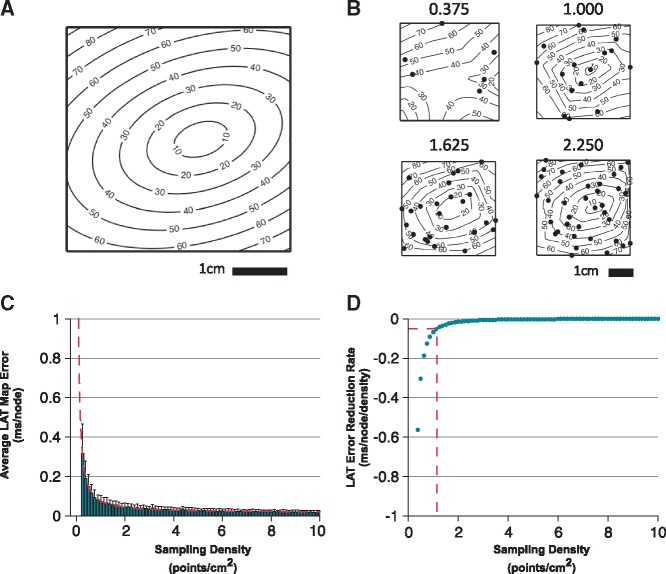
The process used for determination of optimal LAT sampling density. (A) The process is shown for a focal tachycardia in a 4×4 cm monolayer with fiber orientation of 18° to the x-axis. (B) Activation times are re-sampled at increasing sampling density and regional activation is re-interpolated to give the resulting ‘down-sampled’ activation maps. Sampling densities (points/cm2) are given above each example map. (C) Mean normalized LAT map error at each sampling density is calculated by comparing activation times at each node with the original activation times in A. (D) Taking the first-derivative of the curve in ‘C’ indicates the sampling density at which minimal further improvement in map accuracy is generated.